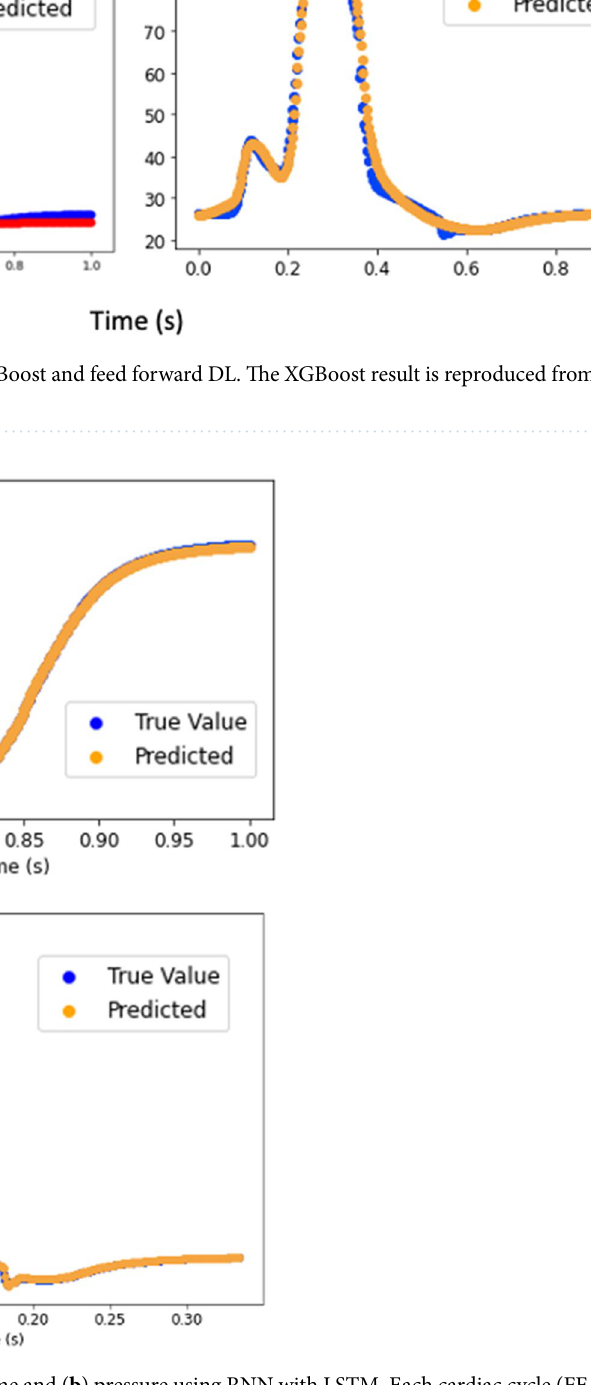
Figure 6. Prediction of LV ( a ) volume and ( b ) pressure using RNN with LSTM. Each cardiac cycle (FE mode) was assumed as a sequence of previous cardiac cycle (FE model). Moreover, at each time point, data from past 20 time points were used to predict current time pressure or